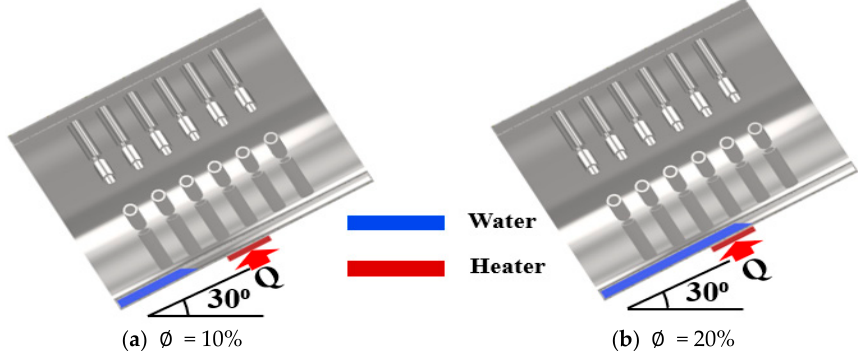
Figure 7. Location of working fluid at different charged ratios with a pitch angle of 30°.